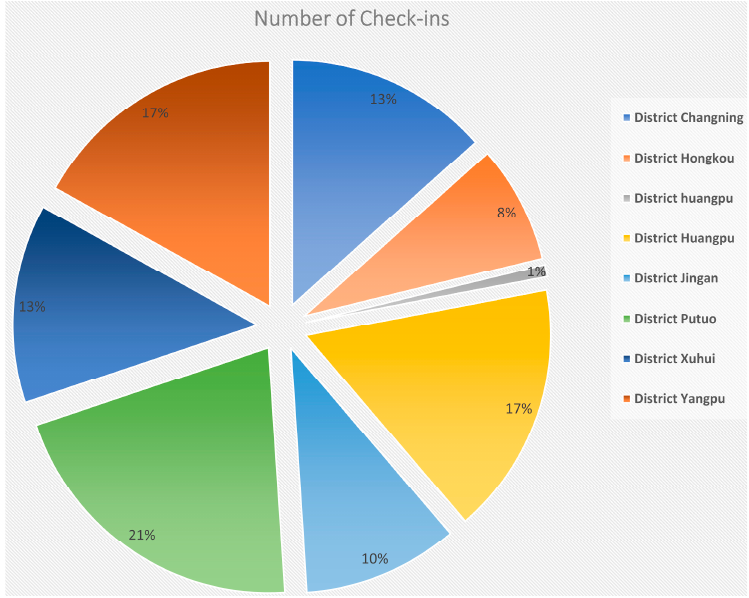
Figure 10. Percentage of check-ins in the districts.